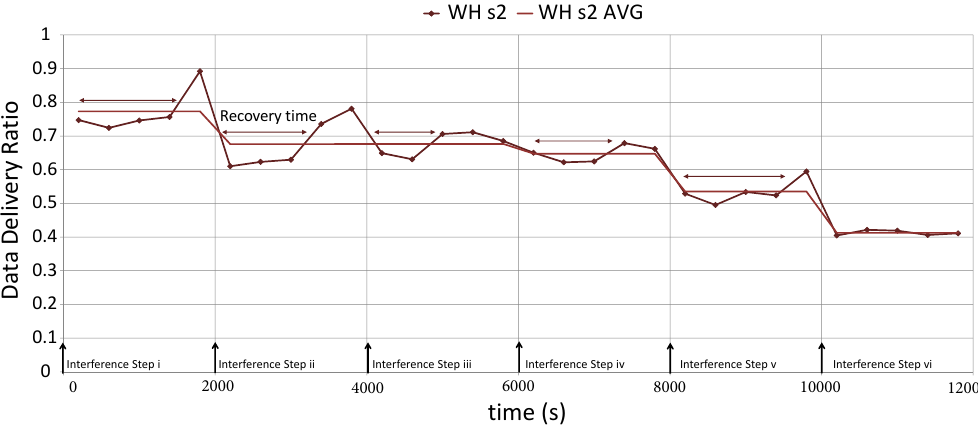
Figure 26. The data delivery ratio difference in two